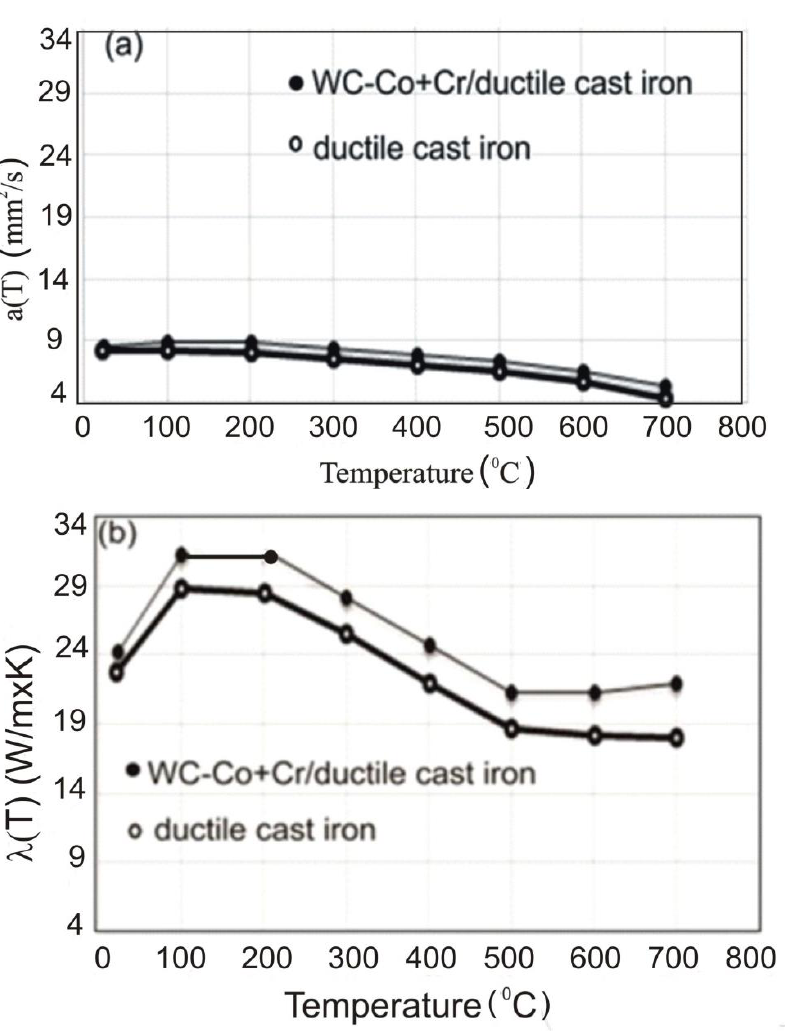
Figure 7. ( a ) Plotted relationship between temperature conductivity a(T); and ( b ) thermal conductivity λ (T) for: WC – Co + Cr/ductile cast iron and ductile cast iron. Table 3. Temperature and thermal conductivity coefficients in function of temperature for ductile cast iron and system : (WC – Co + Cr)/ductile cast iron.